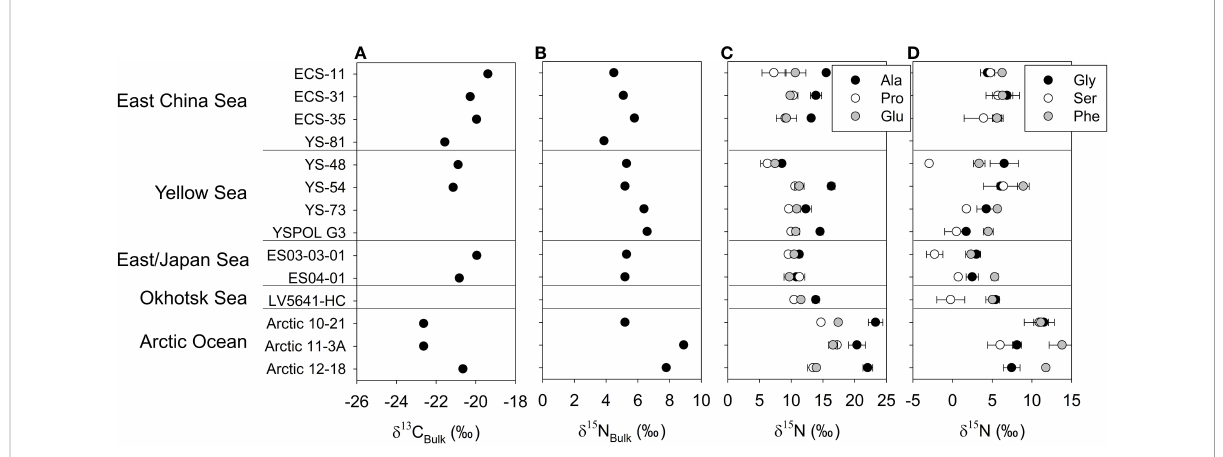
below the sea fl oor (4.1) of the core (Figure 6B). A vertical trend in ∑ V values was not found along the core depth, from 1.1 to 1.5 (Figure 6C and Table S5). The trophic position estimated by glutamic acid and phenylalanine (TP) ranged from 0.9 to 1.5, with an unclear vertical trend (Figure 6D and Table S5). For surface sediments, the DI values were negative and ranged from − 1.49 to − 0.40 (Figure 6E and Table S4), with